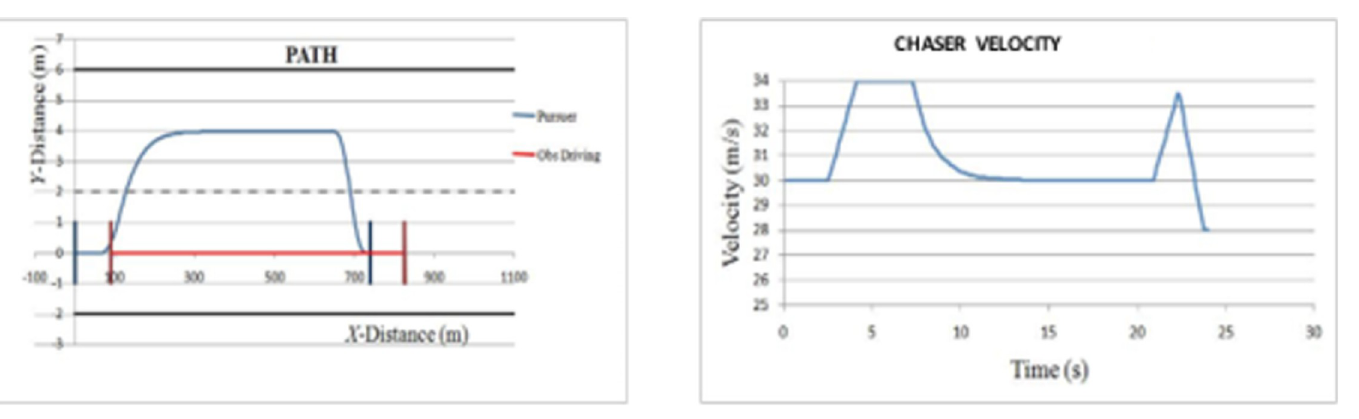
Fig 13. Profiling–velocity and path for C in scenario 3.